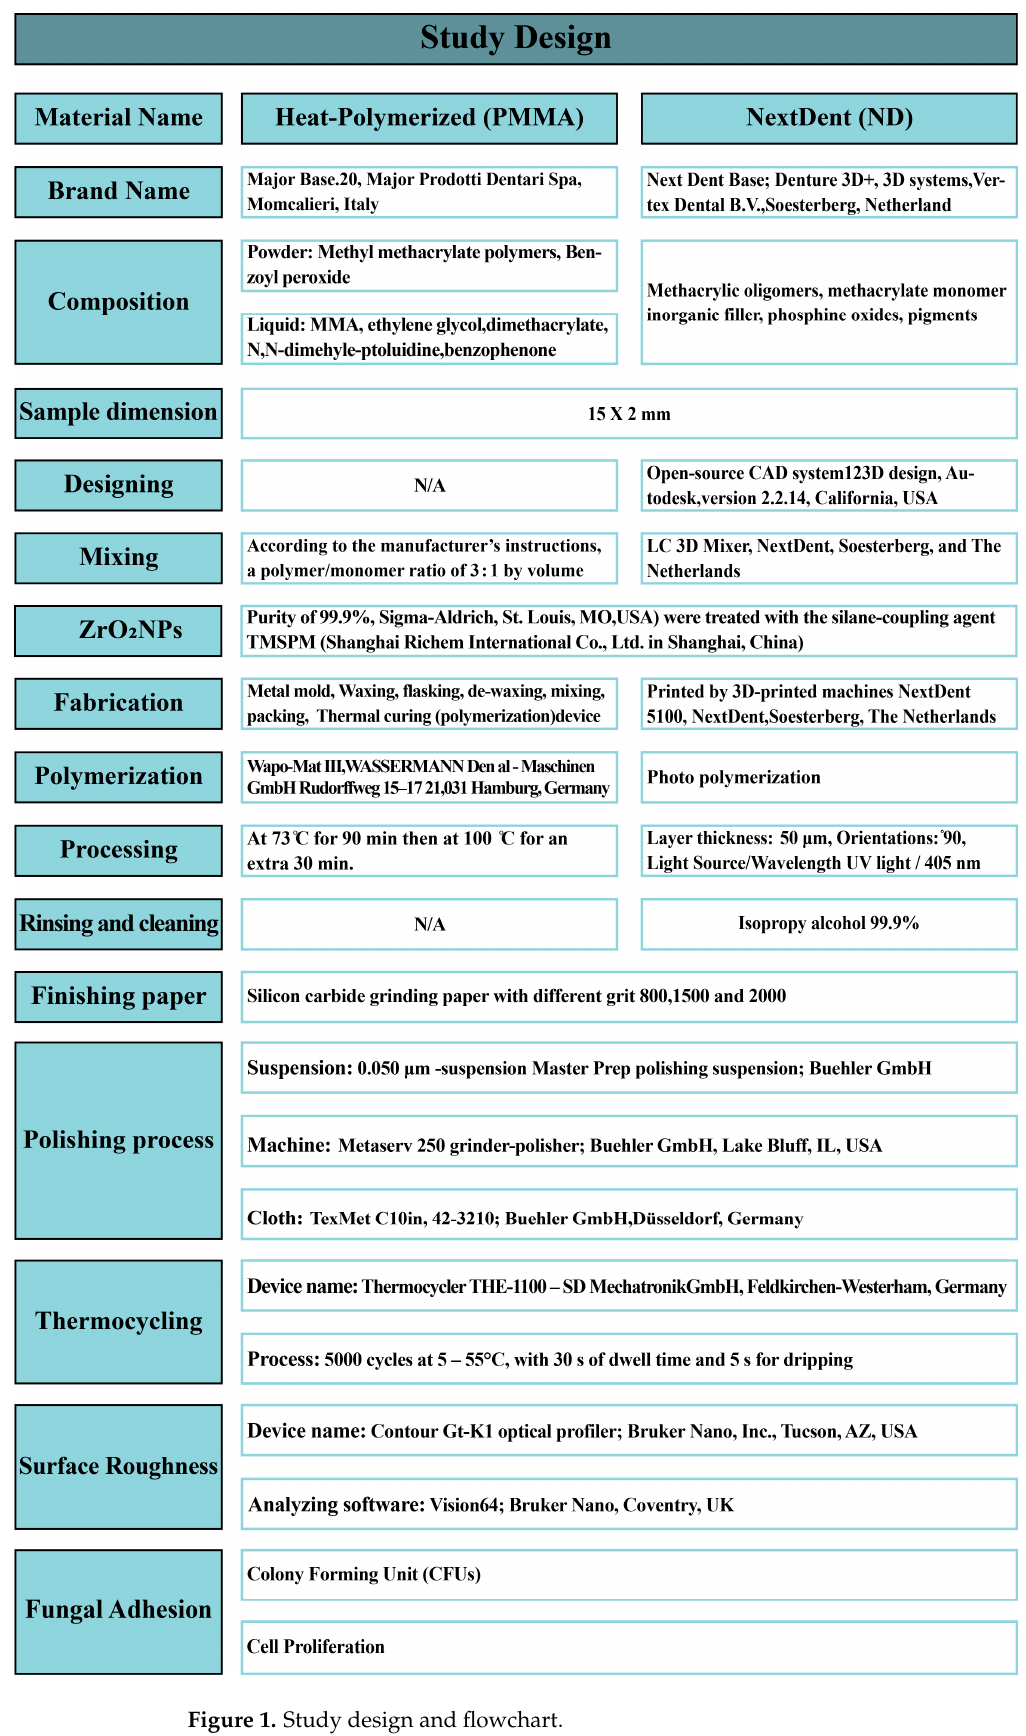
Figure 1. Study design and